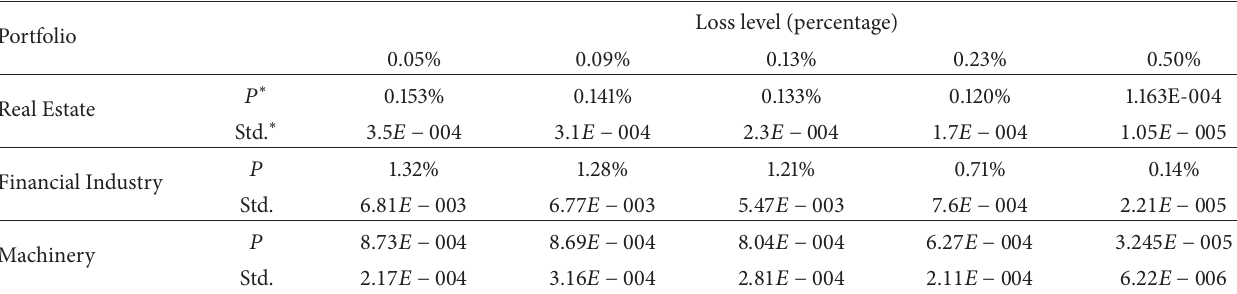
Table 3: Standard deviations of the default